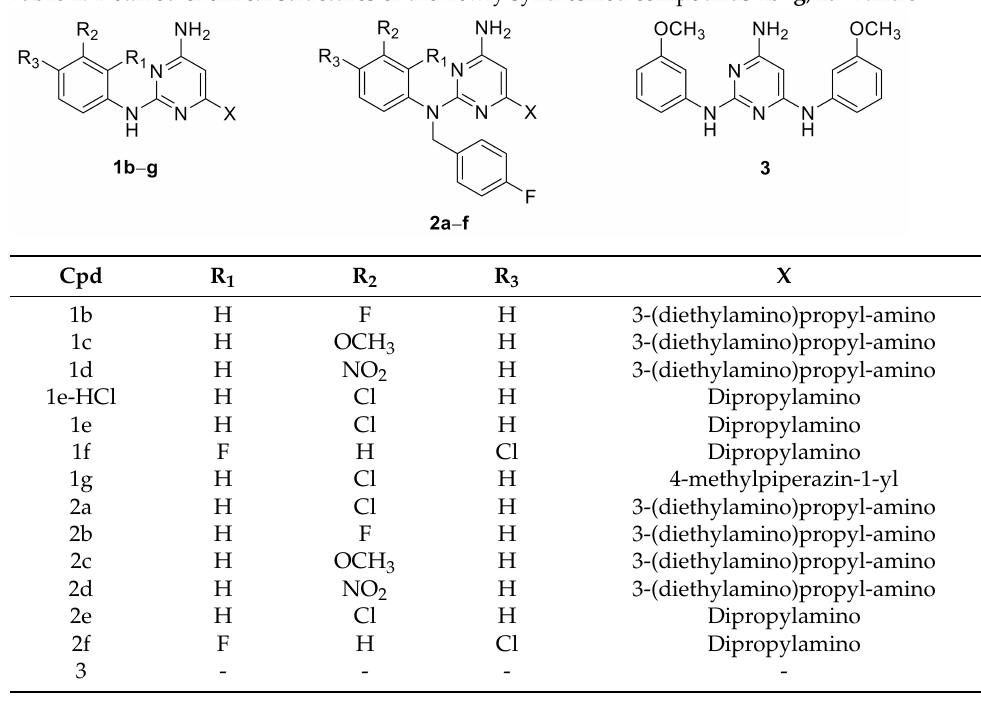
Table 1. Detailed chemical structures of the newly synthesized compounds 1b – g , 2a – f and 3